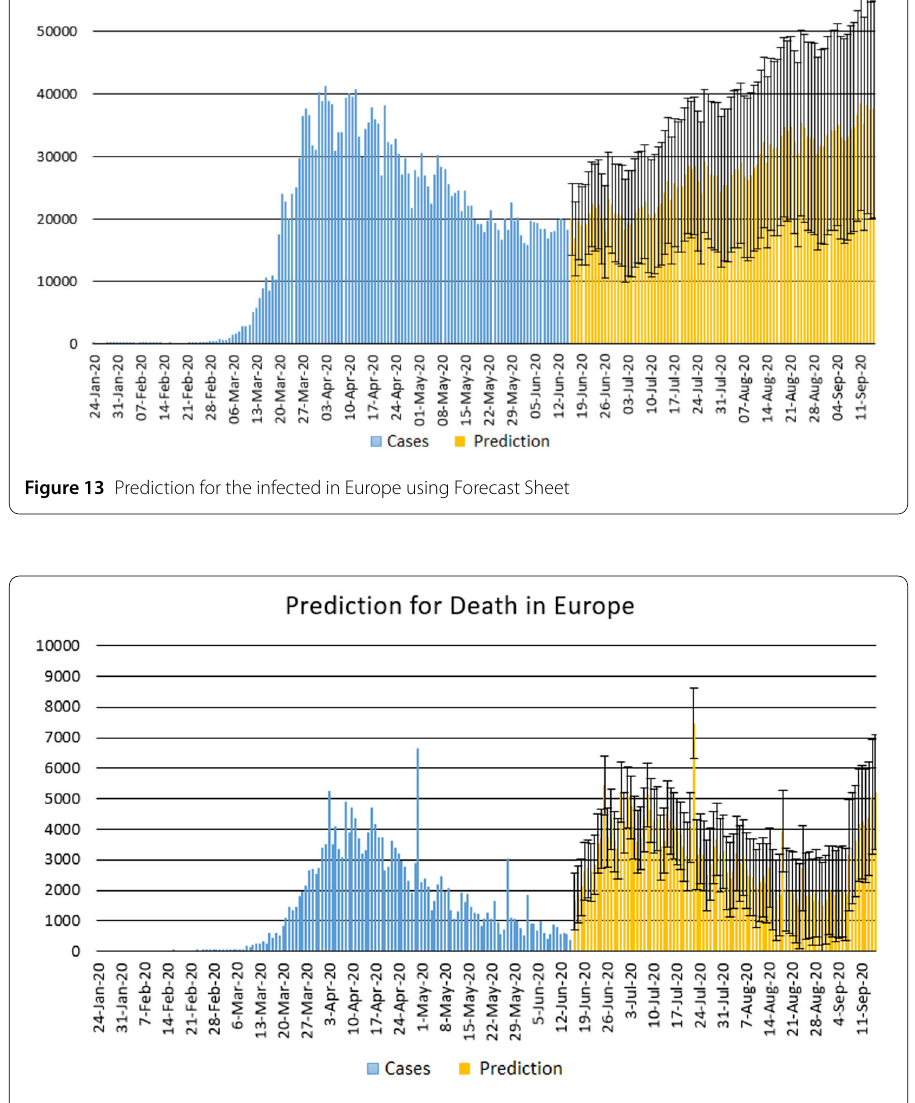
Figure 14 Prediction for deaths in Europe using Forecast